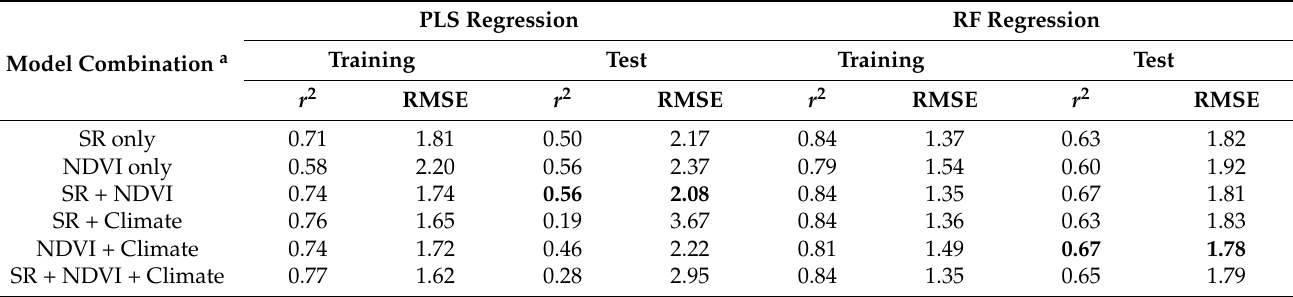
Table 3. Comparison of partial least squares (PLS) and random forest (RF) regression models using several combinations of predictors. PLS Regression Model Combination a